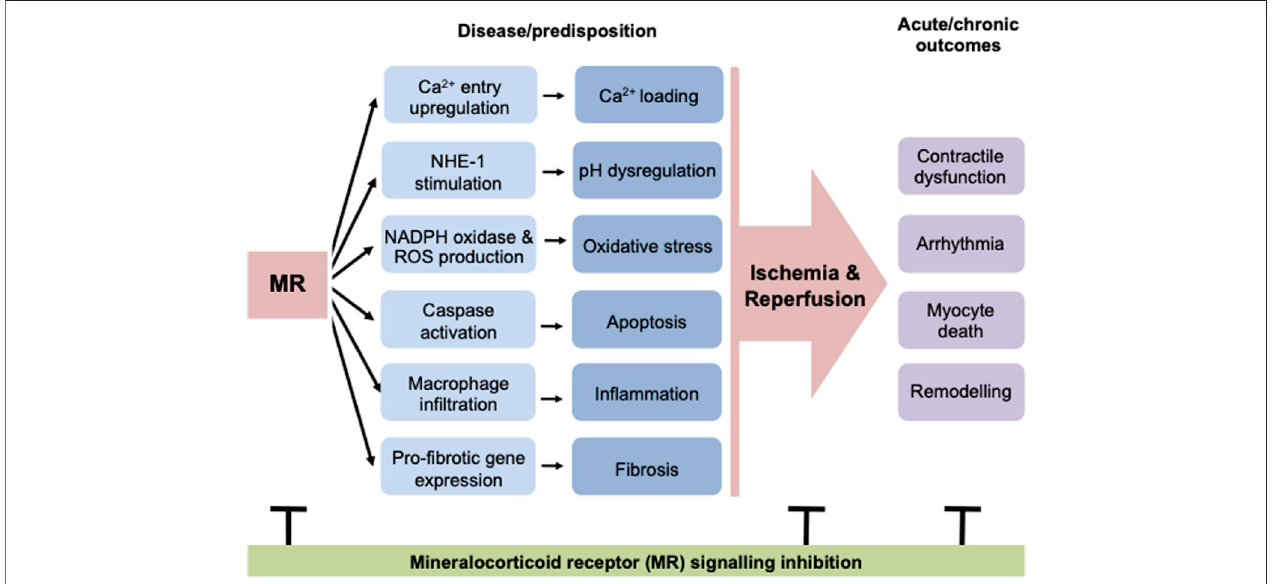
FIGURE 1 | MR activation leads to many detrimental changes in the heart, including cardiomyocyte cell death, in fl ammation and fi brosis. In addition to these structural changes, MR signaling leads to stimulation of calcium and sodium fl ux in cardiomyocytes, predisposing these cells to calcium loading and pH dysregulation. Overall these modulations of basal cardiac structure and function predispose the heart to ischemic events and result in worse outcomes after ischemia/reperfusion, increasing the incidence of contractile dysfunction and arrhythmia and also increasing cell death and consequently reactive fi brosis. The negative impacts of MR activationatastructuralandfunctionallevelcanbeabrogatedatearlyandlatetimepoints,bothbeforeandafteranischemicevent.MR,mineralocorticoidreceptor;NHE- 1, sodium hydrogen exchanger-1; ROS, reactive oxygen species.